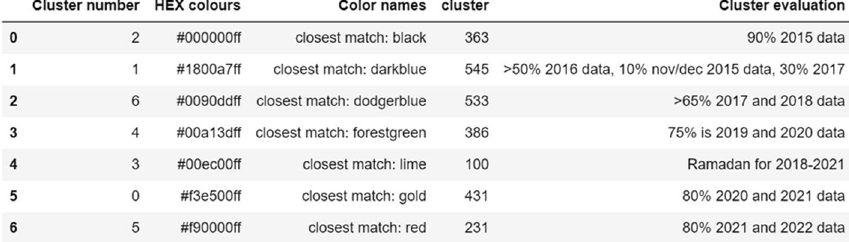
Fig. 10 The dataframe for the seven clusters of electricity load profiles for Lombok Indonesia from 2015 to 2021